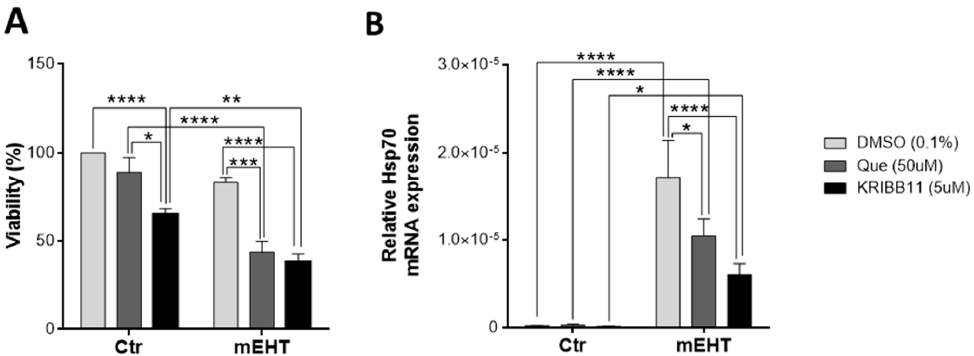
Figure 10. Synergistic effect of mEHT and heat shock inhibitors. 4T1 cells pre-treated with heat shock response inhibitors, Quercetin or KRIBB11, or vehiculum (DMSO) for 1 h before mEHT (42 °C, 30 min) treatment. ( A ) Resazurin viability assay, 24 h post-mEHT, viability expressed as percent of control (37 °C, vehiculum only). ( B ) Hsp70 mRNA 2 h post- mEHT, normalized to 18S rRNA. Two-way ANOVA, Mean ± SEM, n = 5–12/group, * p < 0.05, ** p < 0.01, *** p < 0.001, **** p < 0.0001.